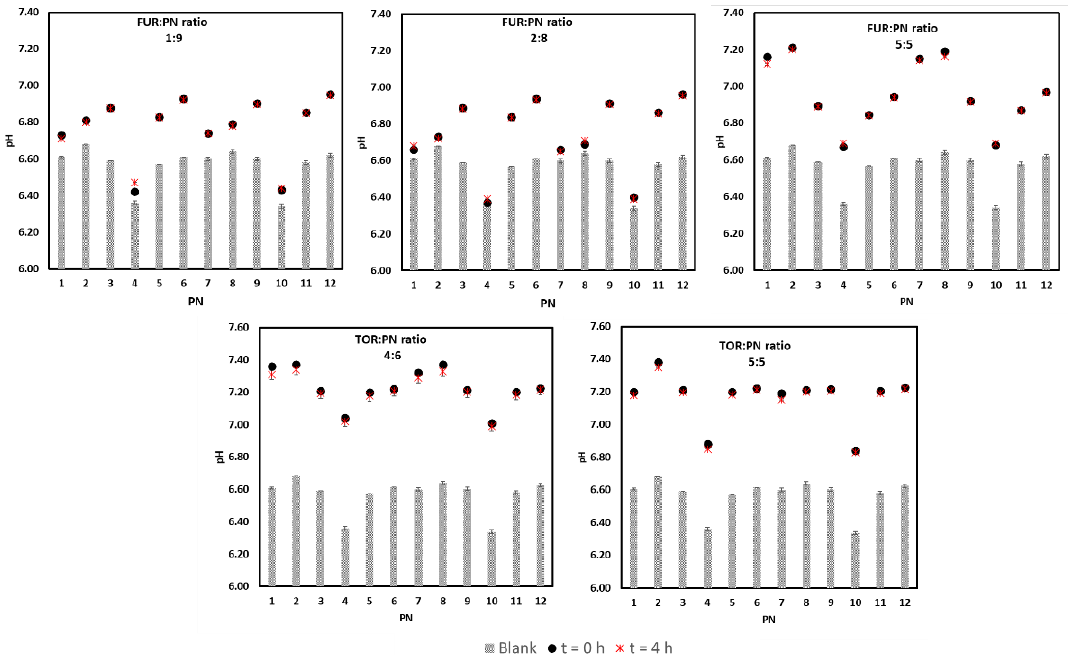
Figure 2. The pH values of drug–PN samples upon preparation and 4 h later (black and red signs), and PN upon preparation (gray bars). The upper part refers to FUR:PN samples in three different ratios, whereas the down part refers to TOR:PN samples in two ratios. FUR, furosemide; PN, parenteral nutrition admixture; TOR, torsemide; Blank, PN without drug.